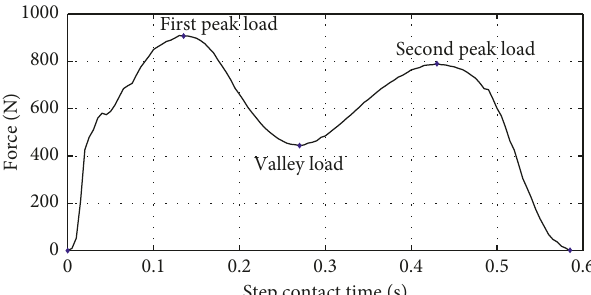
Figure 2: Shape of a typical measured walking step with time and load